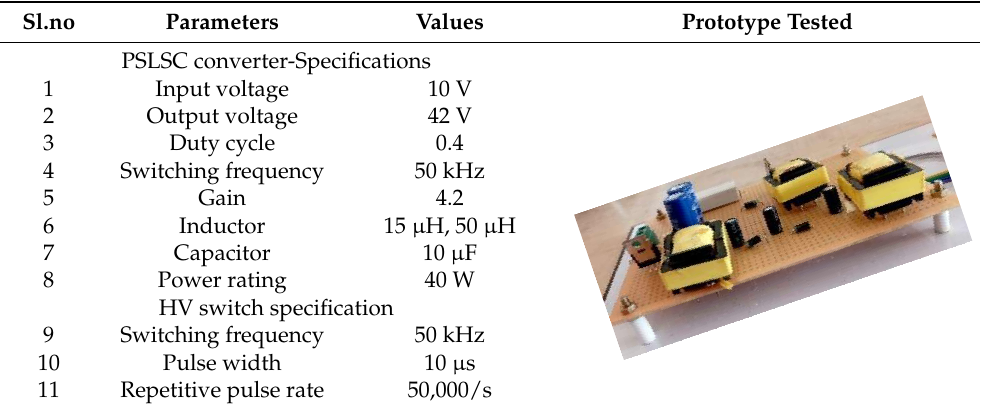
Table 8. Hardware Specifications of PSLSC converter.